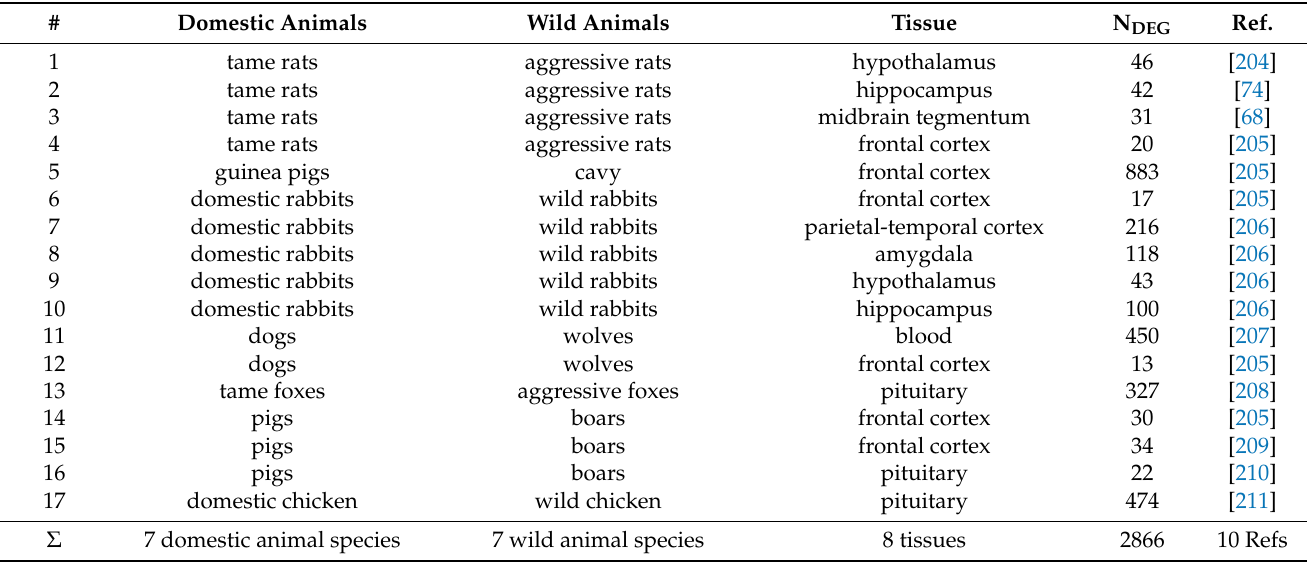
Table 8. RNA-Seq transcriptomes of domestic animals versus their wild conspecifics (PubMed data [75]).